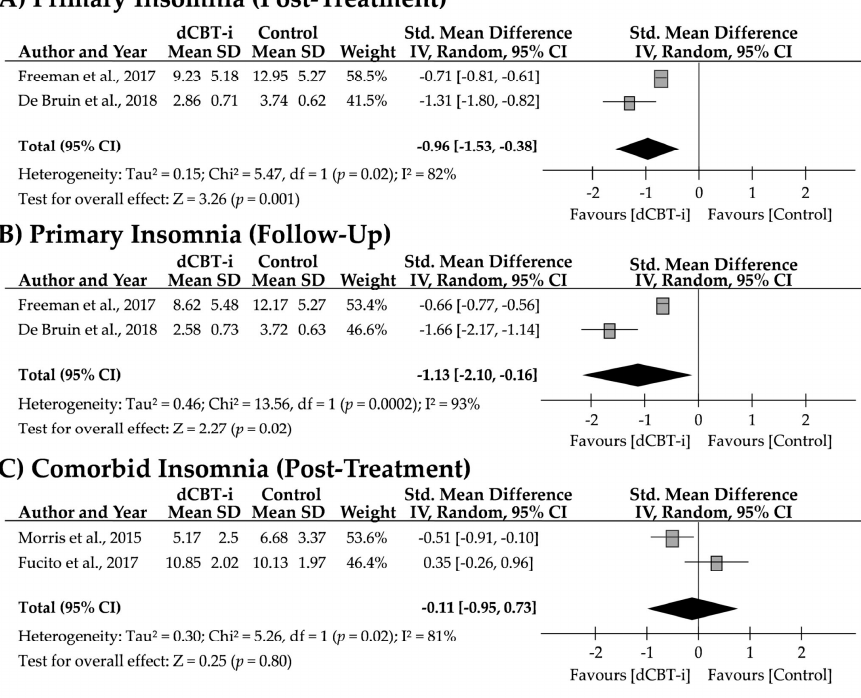
Figure 4. Forest plot for short- and long-term effects of dCBT-i on subjective sleep quality among insomnia subtypes. Subjective sleep quality was evaluated using the PSQI (Morris et al., 2015 [30]; Fucito et al., 2017 [44]), ISI (Freeman et al., 2017 [43]), or HSDQi (De Bruin et al., 2018 [45]). SD, standard deviation; CI, confidence interval.